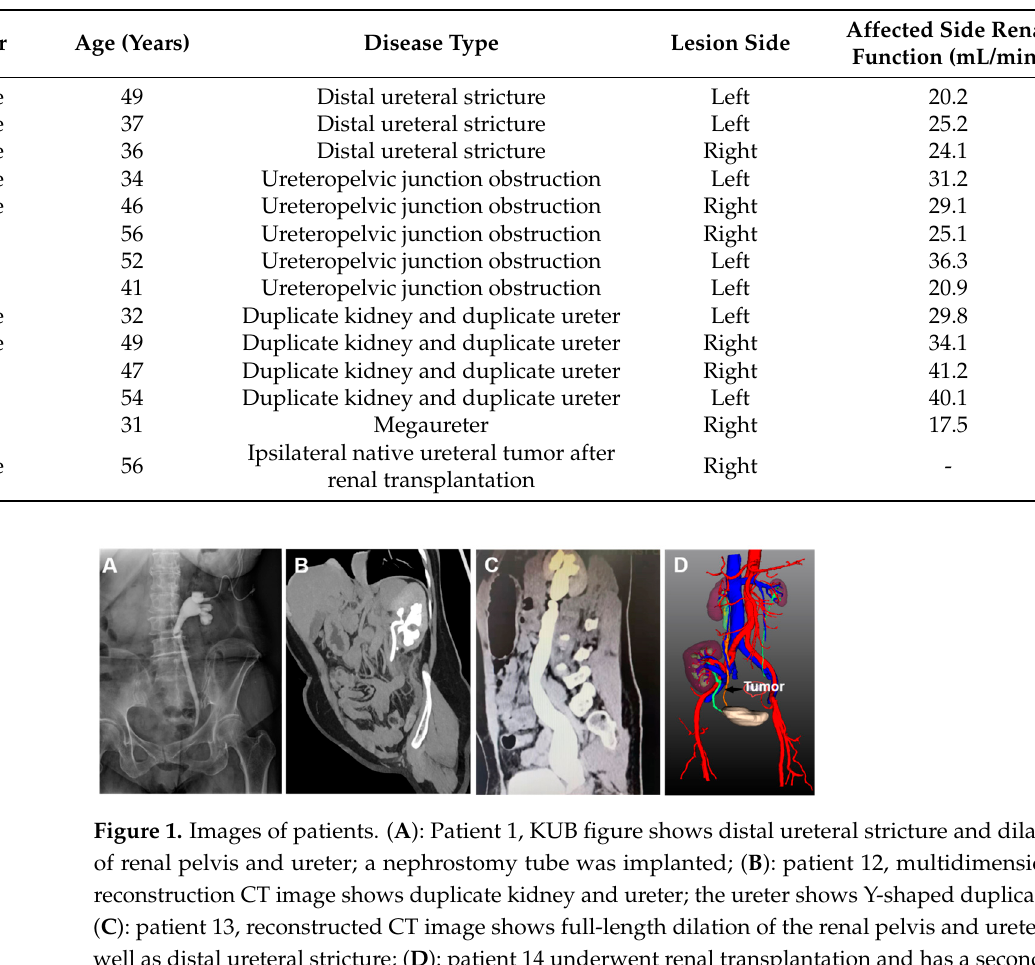
Table 1. General characteristics of patients.